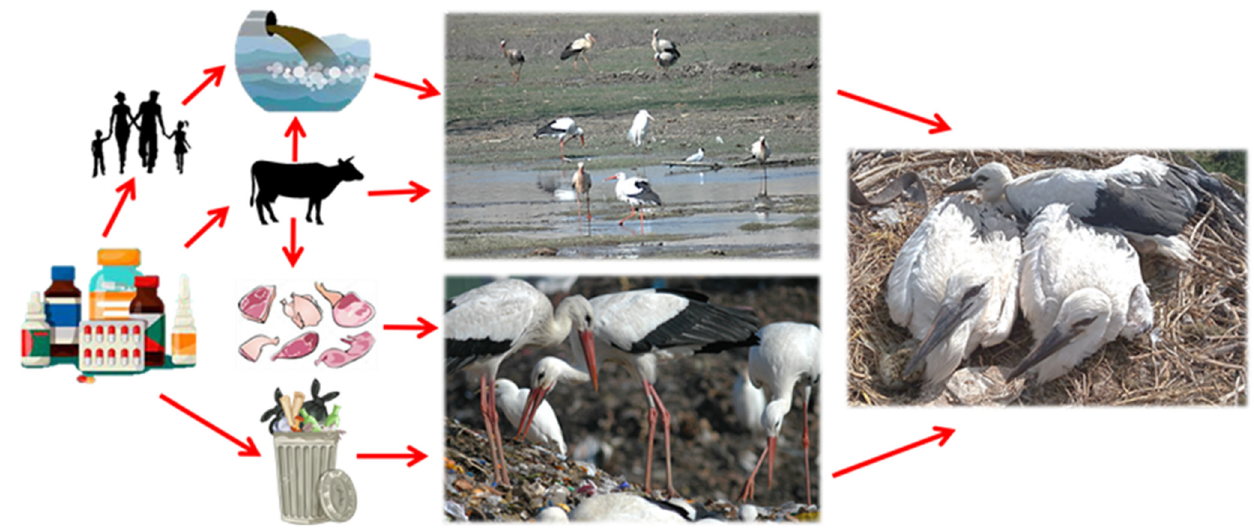
Figure 1. Schematic representation of the potential sources of contamination and pathways of exposure of white storks to pharmaceuticals used in human and veterinary